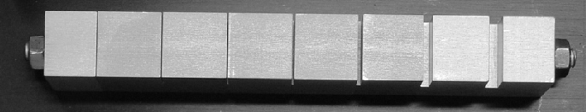
Figure 11. Gap feature as structure standard.